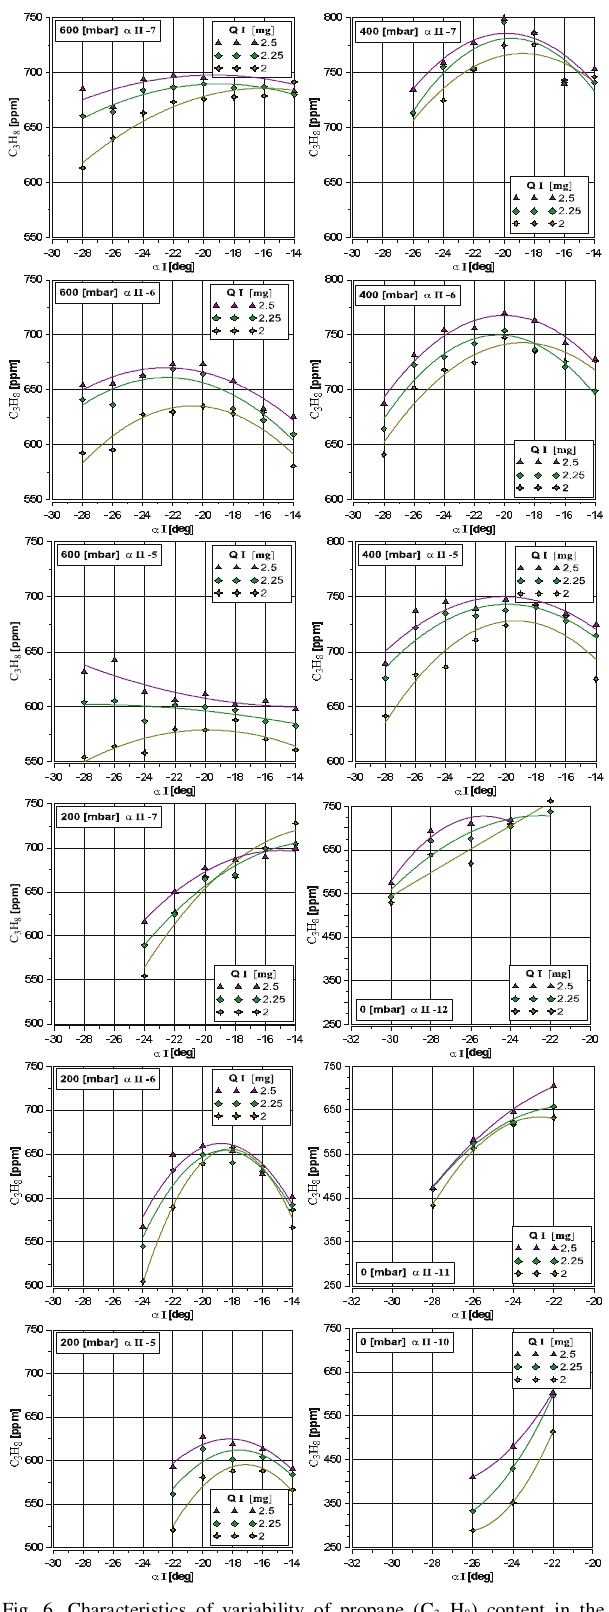
Fig. 6. Characteristics of variability of propane (C 3 H 8 ) content in the exhaust for different injection parameters of diesel fuel dose initiating